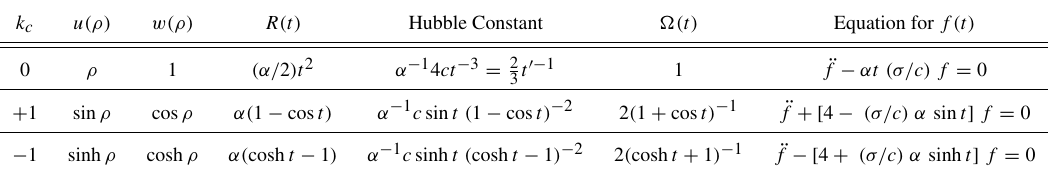
Curvature k c , u(ρ) , w(ρ) , R(t) , and equations to be